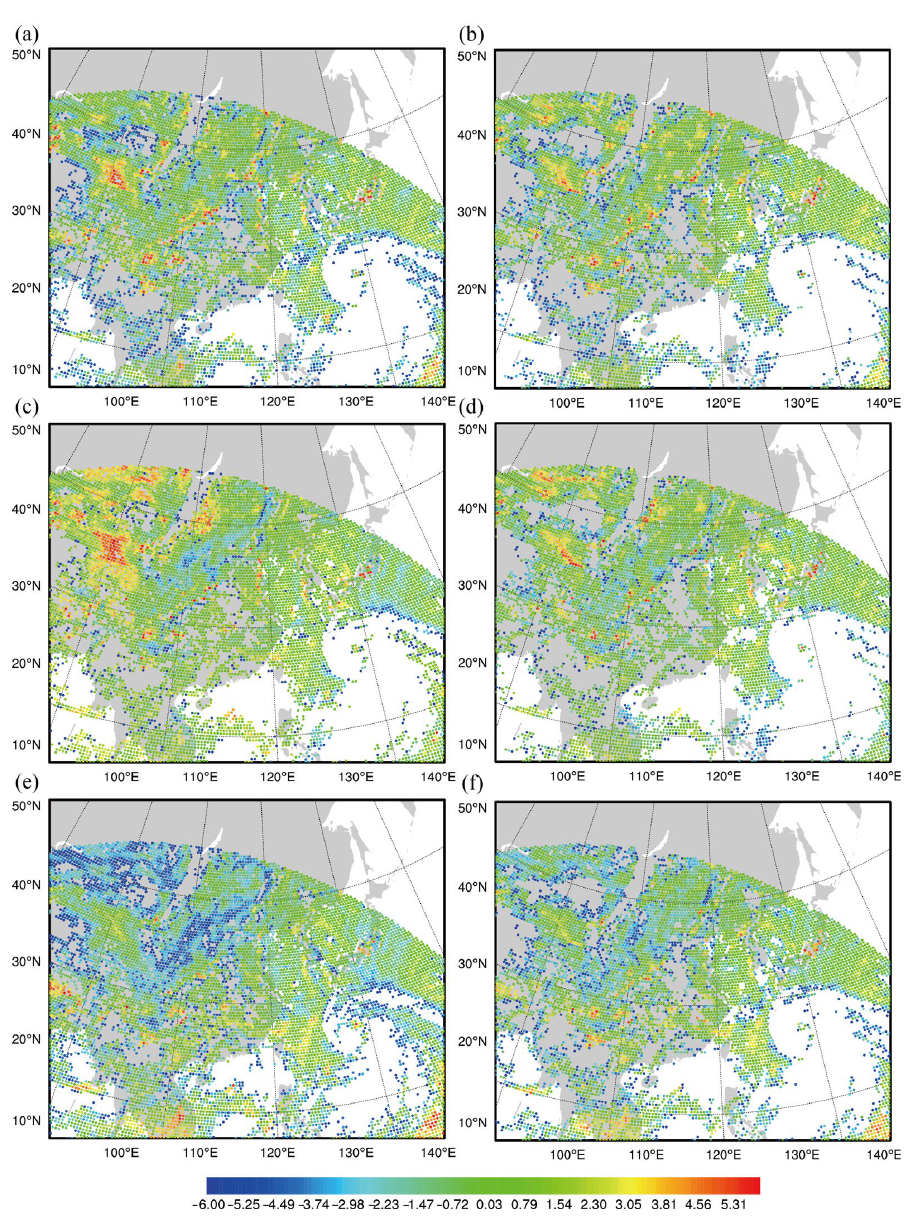
Figure 9. The brightness temperature (unit: K) distributions of the observation minus the background (OMB) before the bias correction for AGRI ( a ) channel 9 and ( b ) channel 10, after the bias correction from the RF_pre7 experiment for AGRI ( c ) channel 9 and ( d ) channel 10, and from the Linear_pre7 experiment for AGRI ( e ) channel 9 and ( f ) channel 10, valid at 0600 UTC 19 July 2021.